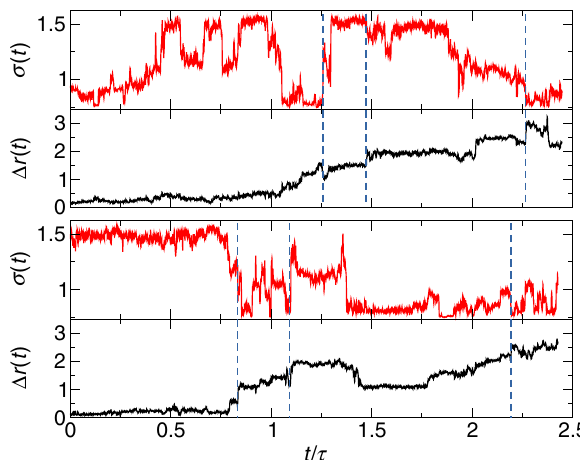
FIG. 12. Nonadditive model of Sec. IV C with ϵ ¼ 0 . 2 . (a) Time autocorrelation of particle diameters C σ ð t Þ measured during the swap dynamics for temperatures, as in Fig. 4. (b) Relaxation times τ α , τ σ , and τ as a function of temperature, with τ σ and τ o o rescaled to coincide with τ α at T ¼ 0 . 175 (shown with the horizontal bar). The three time scales obviously have the same temperature